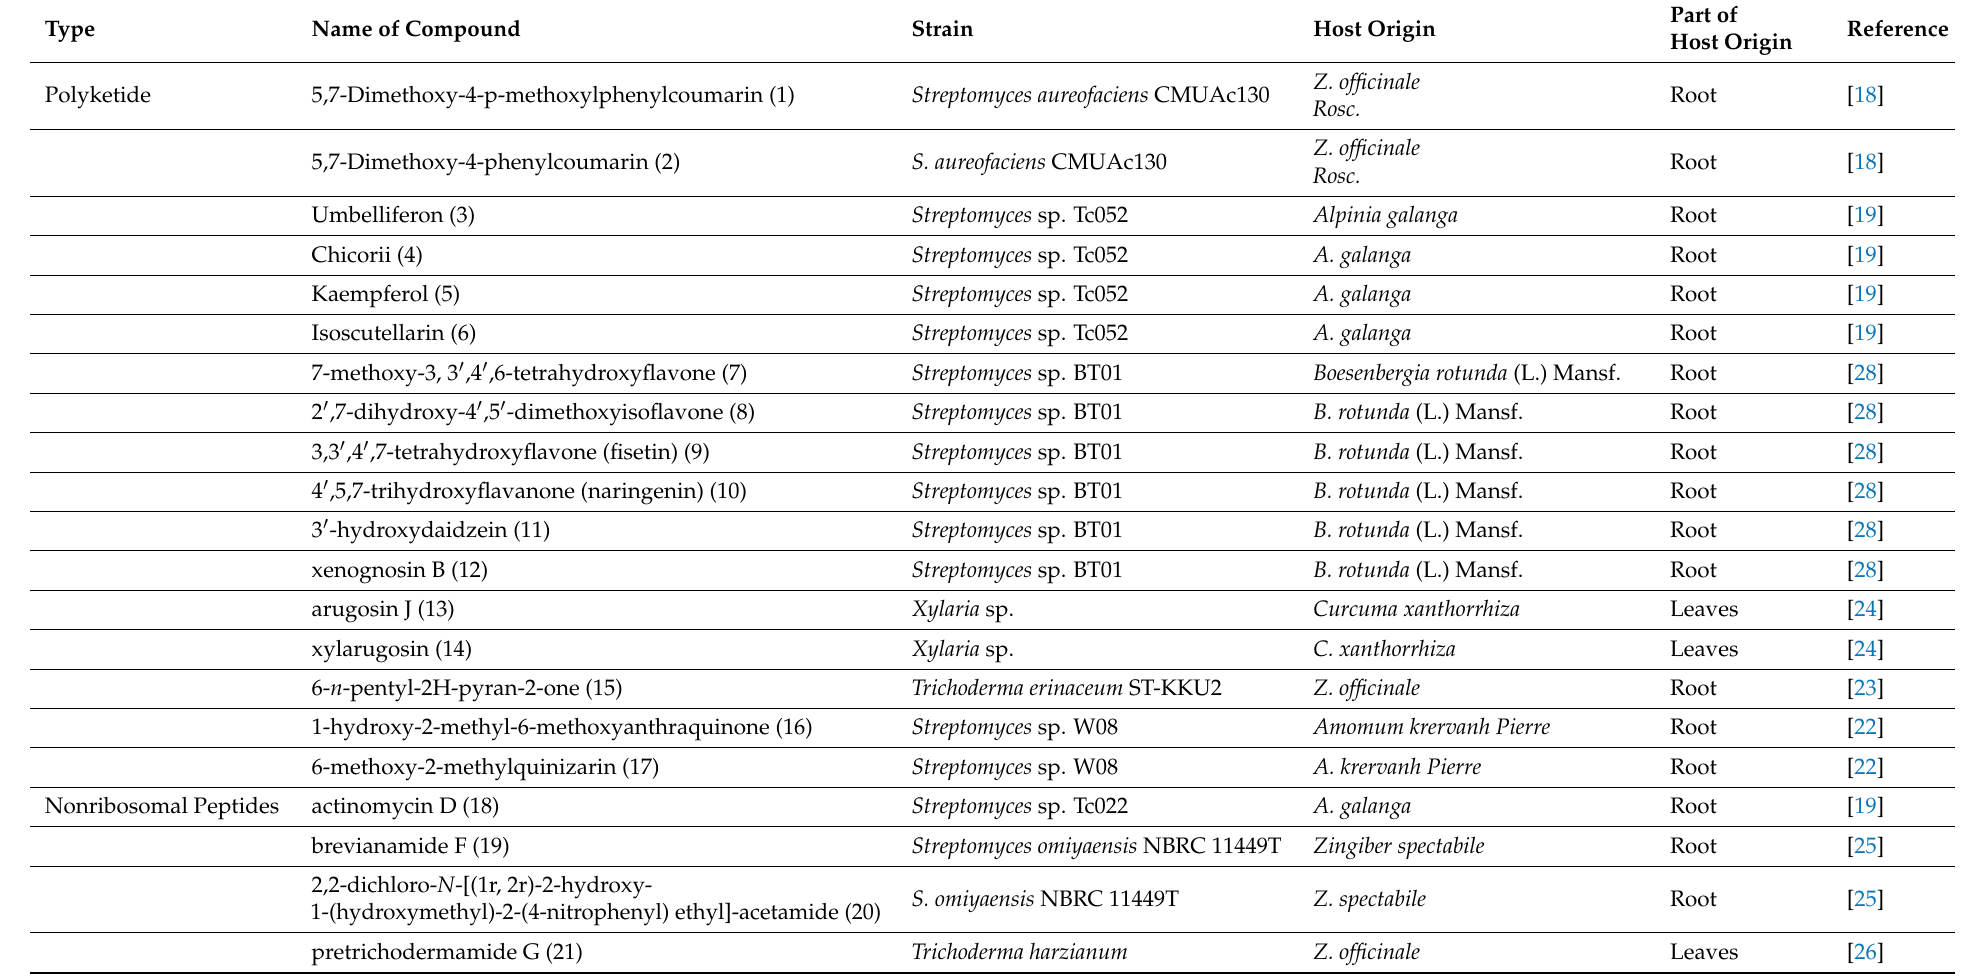
Table 1. Compounds isolated from Zingiberaceae